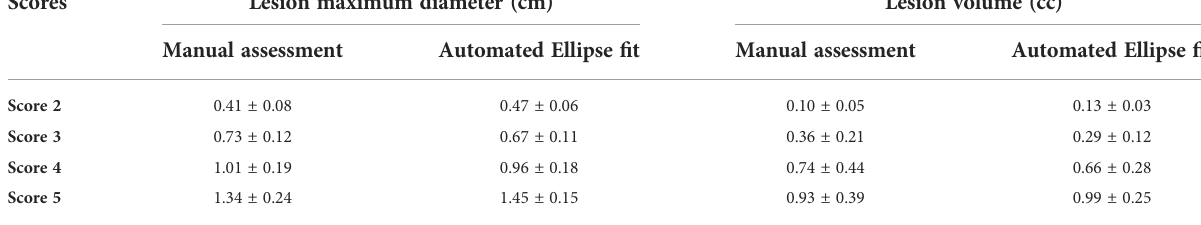
TABLE 1 Lesion maximum diameter and volume for different PI-RADS v2.1 scores, in terms of mean ± standard deviation (SD); SD was calculated across all subjects within each score. Scores